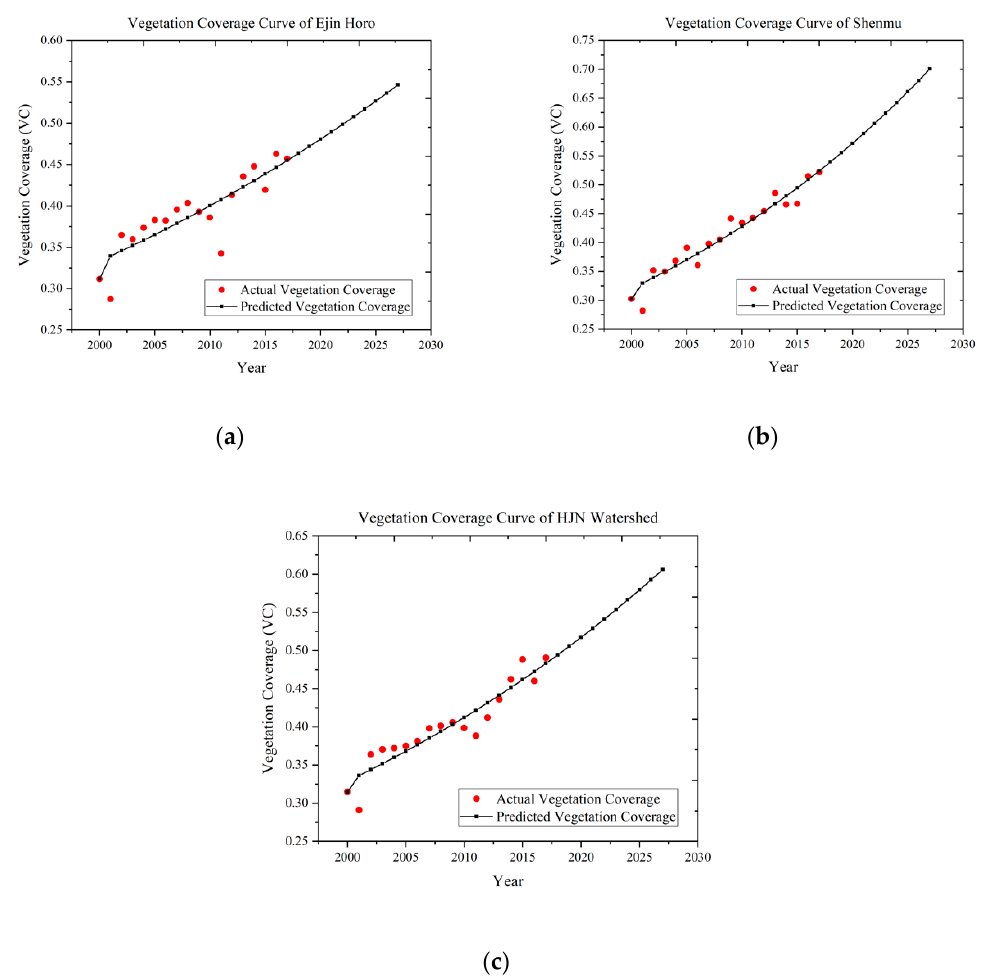
Figure 7. Forecasted VC trends in the HJN watershed, Ejin Horo, and Shenmu in the next decade using a grey forecasting model (GM (1, 1) (Grey Model (1,1))). The red points represent the actual VC from 2000 to 2017 and the black line represents the predicted VC to 2027. ( a ) is the forecasted VC trends in the Ejin Horo; ( b ) is the forecasted VC trends in the Shenmu; ( c ) is the forecasted VC trends in the HJN watershed.